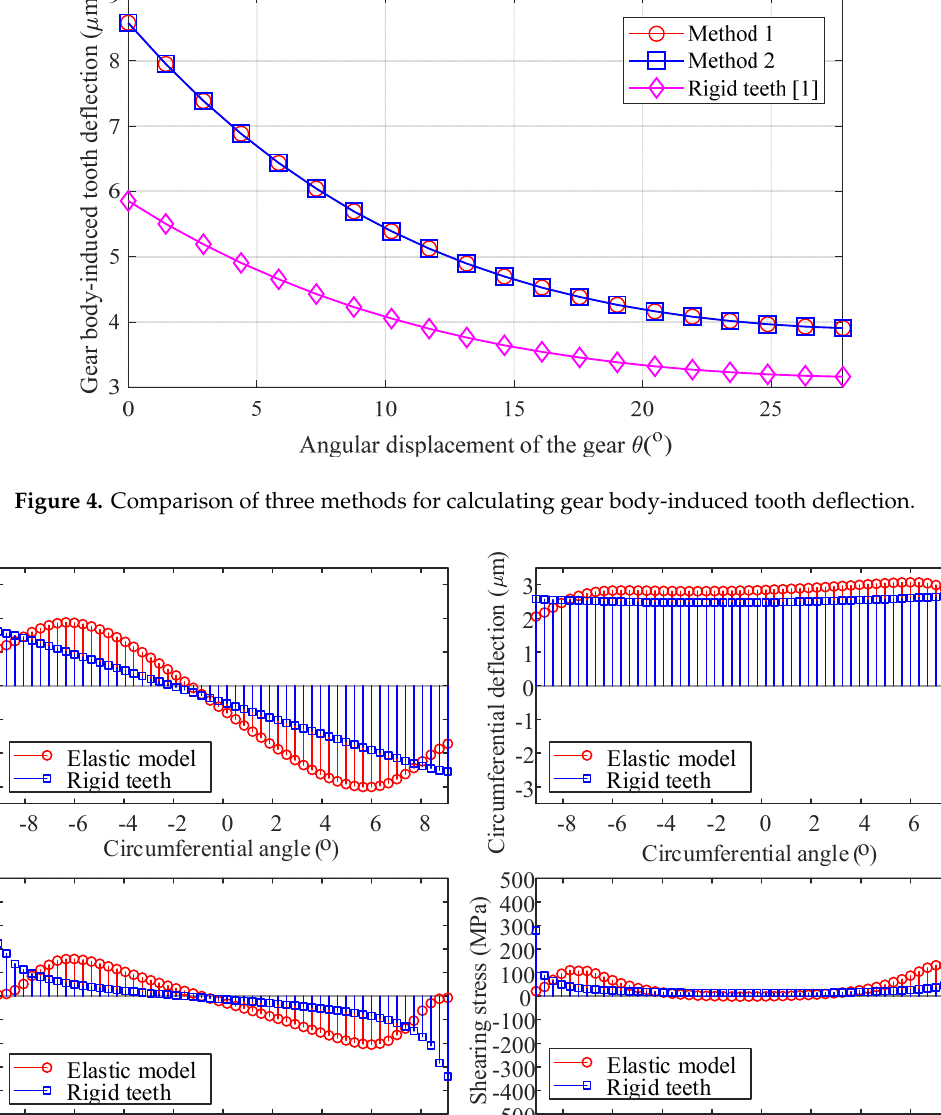
Figure 4. Comparison of three methods for calculating gear body-induced tooth deflection.